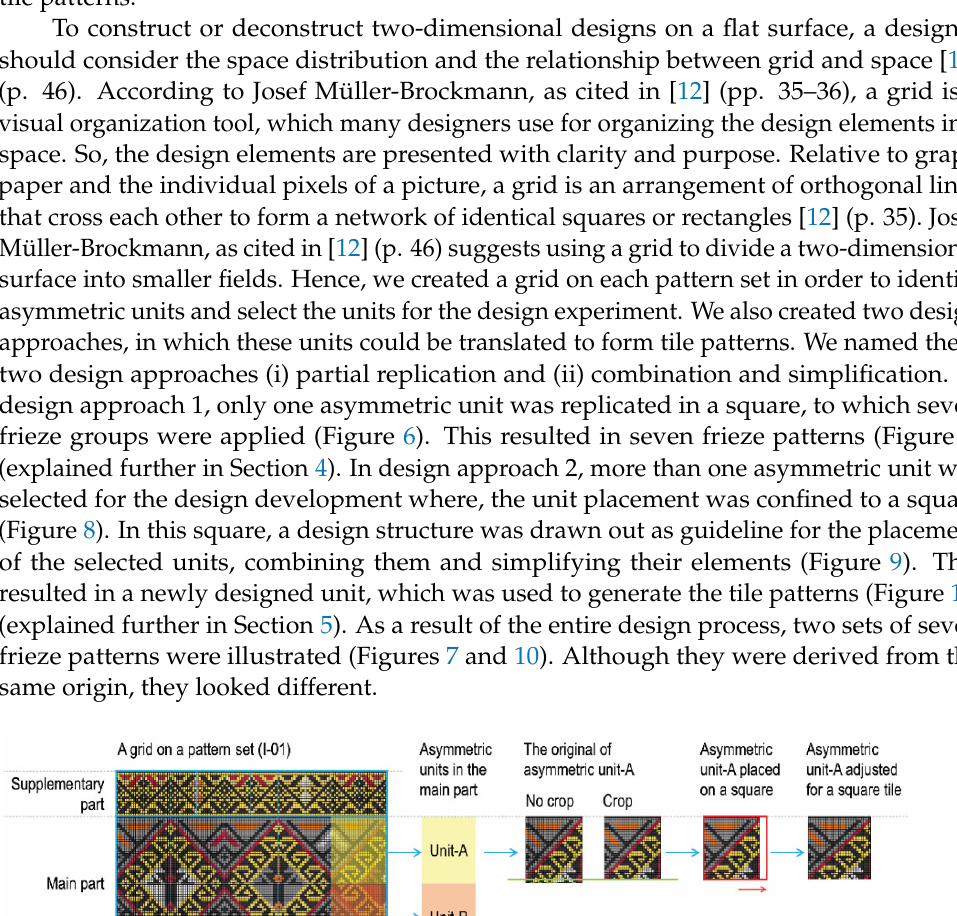
Figure 7. Design derivations from ‘design approach 1’. F1 – F7 represent sets of symbols for the seven frieze groups as indicated in Figure 3. Red arrows indicate tile placement in a horizontal orientation, similarly to translation. (Illustration by Kunkhet and Chudasri).